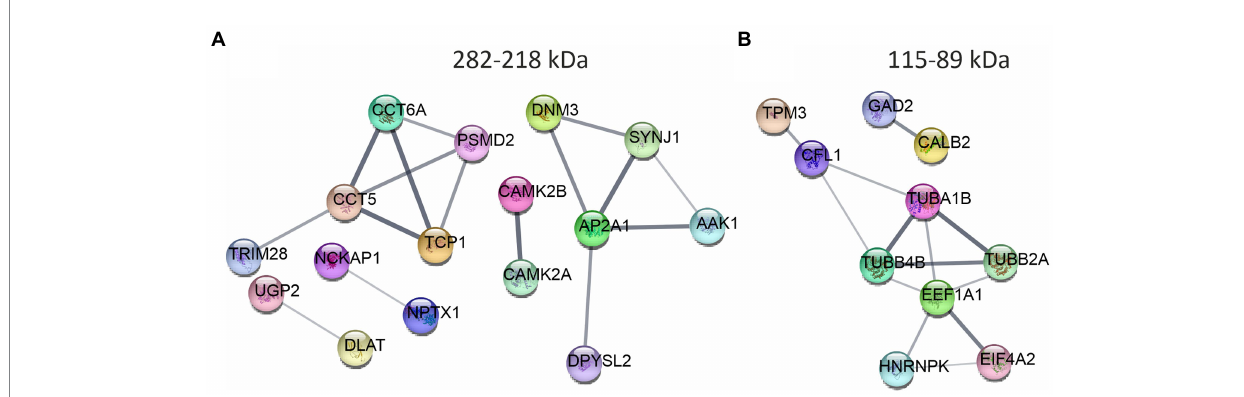
FIGURE 5 The networks of proteins composing complexes with ataxin-3 identified by ion exchange chromatography (IEC) and size using size exclusion chromatography (SEC) followed by LC–MS/MS. The networks were generated using String database and clustering (STRING Network p < 10e-16) (https://string-db.org/). (A) The fraction 282–218 kDa contains highly downregulated Camk2a, CamK2b, proteins belonging to Chaperon Containing TCP1-complex, and proteins being part of the adaptor protein 2 complexes. (B) In the fraction 115–89 kDa proteins responsible for the translation initiation process: Hnrnpk and Eif4a2 were highly enriched in the Ki150 brains. Proteins characteristic for the GABAergic neurons Gad2, Calb2 and Pcp2 were also altered. N =